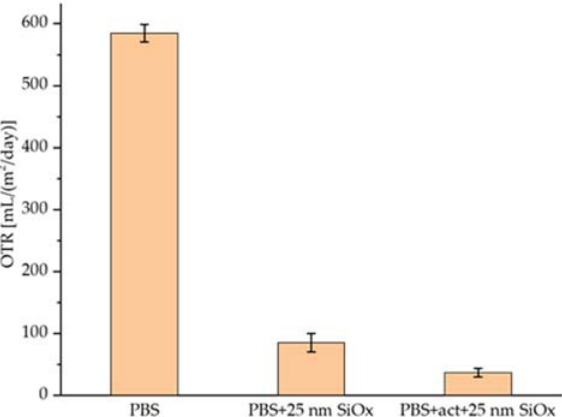
Figure 10. Oxygen transmission rate (OTR) of PBS, PBS coated with 25 nm of SiO x , and functionalized PBS coated with 25 nm of SiO x . The tests were performed at 25 °C and 50 % relative humidity (film thickness was 30 μ m).